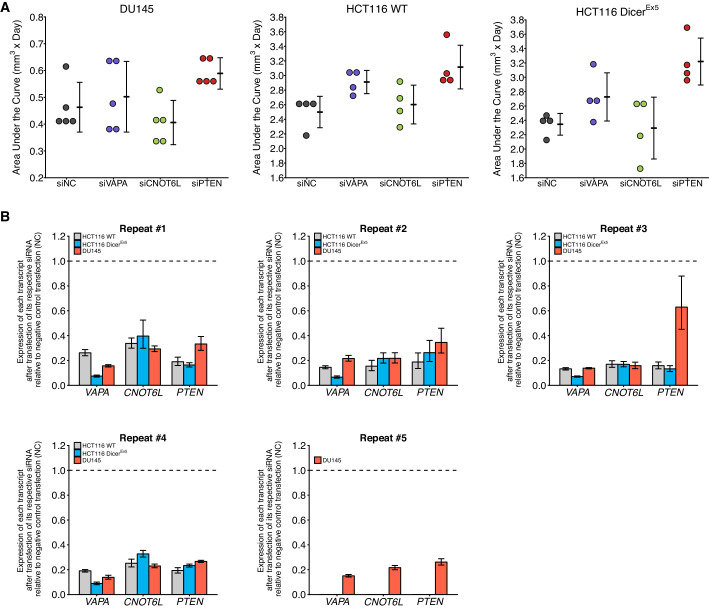
Knockdown efficiency and individual repeats of cell growth assay in cells transfected with siRNA against PTEN ceRNAs.This is the same experiment as Figure 5. (A) Independent biological repeats of cell growth assay. Dot plot with means reported as crossbars and error bars represent SD. (B) Independent biological repeats of RT-qPCR analysis. Expression of each transcript after transfection of its respective siRNA relative to negative control transfection (siNC) is presented. Transcripts listed on y-axis. Means reported and error bars represent SD from three technical replicates. One-sample t-tests of transcript expression data after transfection of respective siRNA to a constant of 1 (relative value of siNC). DU145 cells: VAPA: t(4) = 58.6, uncorrected p=5.09×10−7, Bonferroni corrected p=1.53×10−6; CNOT6L: t(4) = 36.3, uncorrected p=3.42×10−6, Bonferroni corrected p=1.03×10−5; PTEN: t(4) = 9.05, uncorrected p=8.27×10−4, Bonferroni corrected p=0.0025. Wild-type HCT116 cells: VAPA: t(3) = 18.6, uncorrected p=3.40×10−4, Bonferroni corrected p=0.0010; CNOT6L: t(3) = 108, uncorrected p=1.73×10−6, Bonferroni corrected p=5.19×10−6; PTEN: t(3) = 28.1, uncorrected p=9.90×10−5, Bonferroni corrected p=2.97×10−4. DicerEx5 HCT116 cells: VAPA: t(3) = 14.8, uncorrected p=6.73×10−4, Bonferroni corrected p=0.0020; CNOT6L: t(3) = 27.9, uncorrected p=1.02×10−4, Bonferroni corrected p=3.05×10−4; PTEN: t(3) = 178, uncorrected p=3.89×10−7, Bonferroni corrected p=1.17×10−6. Additional details for this experiment can be found at https://osf.io/5c7sb/.